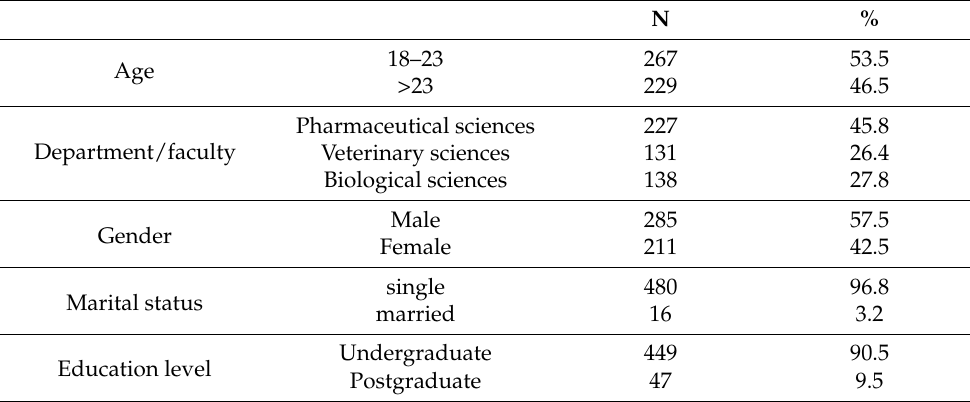
Table 1. Demographic characteristics of the participants.